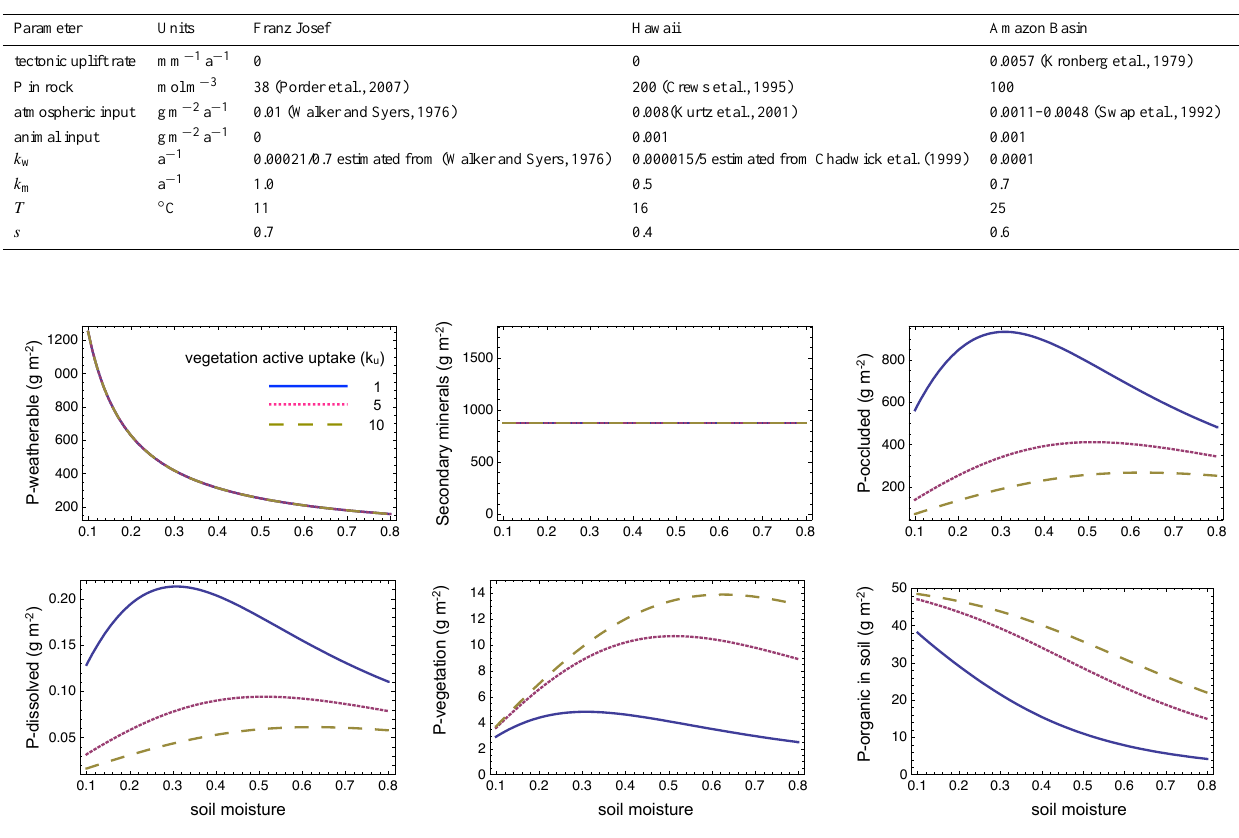
Table 3. Parameter description for specific simulations.